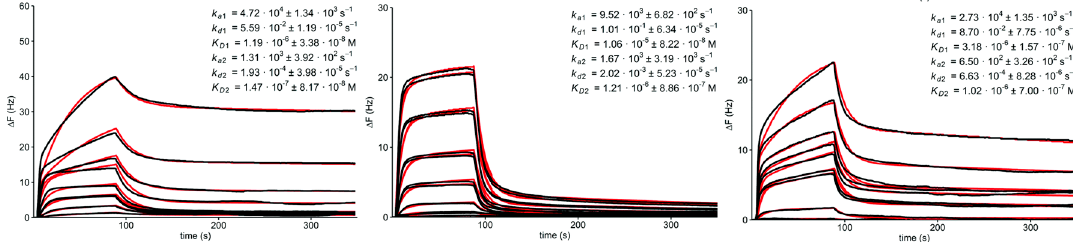
Figure 12. QCM sensorgrams (black curves) and fitted datasets (red curves) for (from left to right): molecular Borromean rings, dodecaamine cages and fullerenes together with estimated binding data. Reproduced with permission from [115].